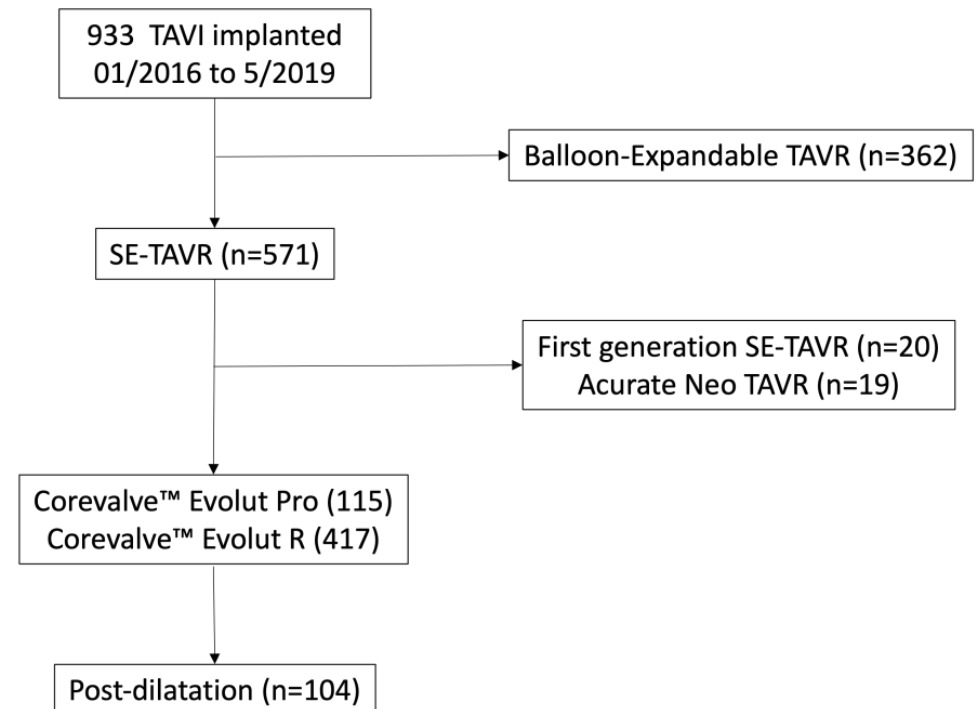
Figure 1. Study flowchart. SE-TAVR: self-expandable transaortic valve replacement.